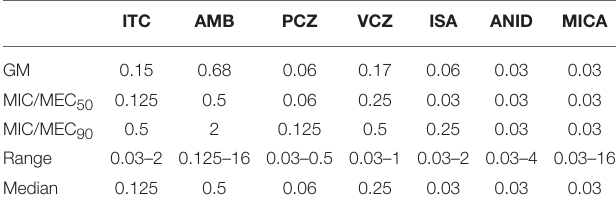
TABLE 5 | Geometric mean (GM), MIC/MEC 50 / 90 , range and median of Aspergillus MICs.